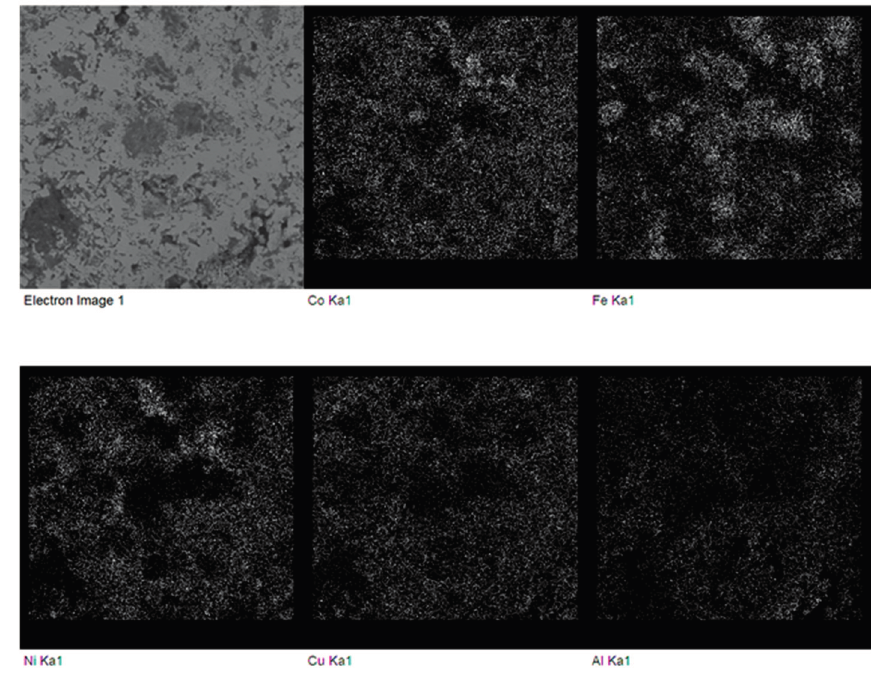
Figure 7. Backscattered electron SEM micrograph and elemental maps of the FeCoNiCuAl sample after microwave heating at 240 W, 5800 MHz, in regions of the predominant electric field of the applicator (forming pressure = 300 MPa). White dots indicate a higher concentration of the element specified below each